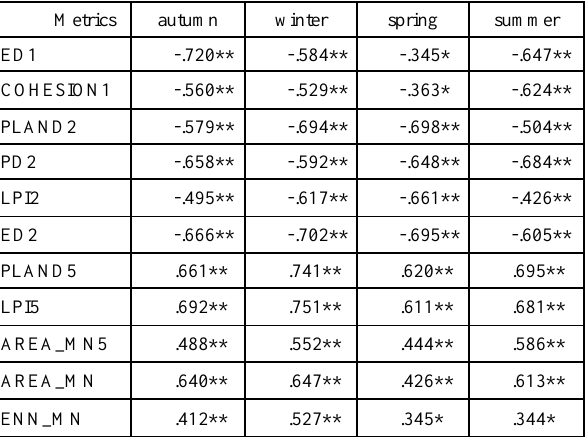
Table 2. Correlation analysis on surface net radiation and landscape metrics across seasons